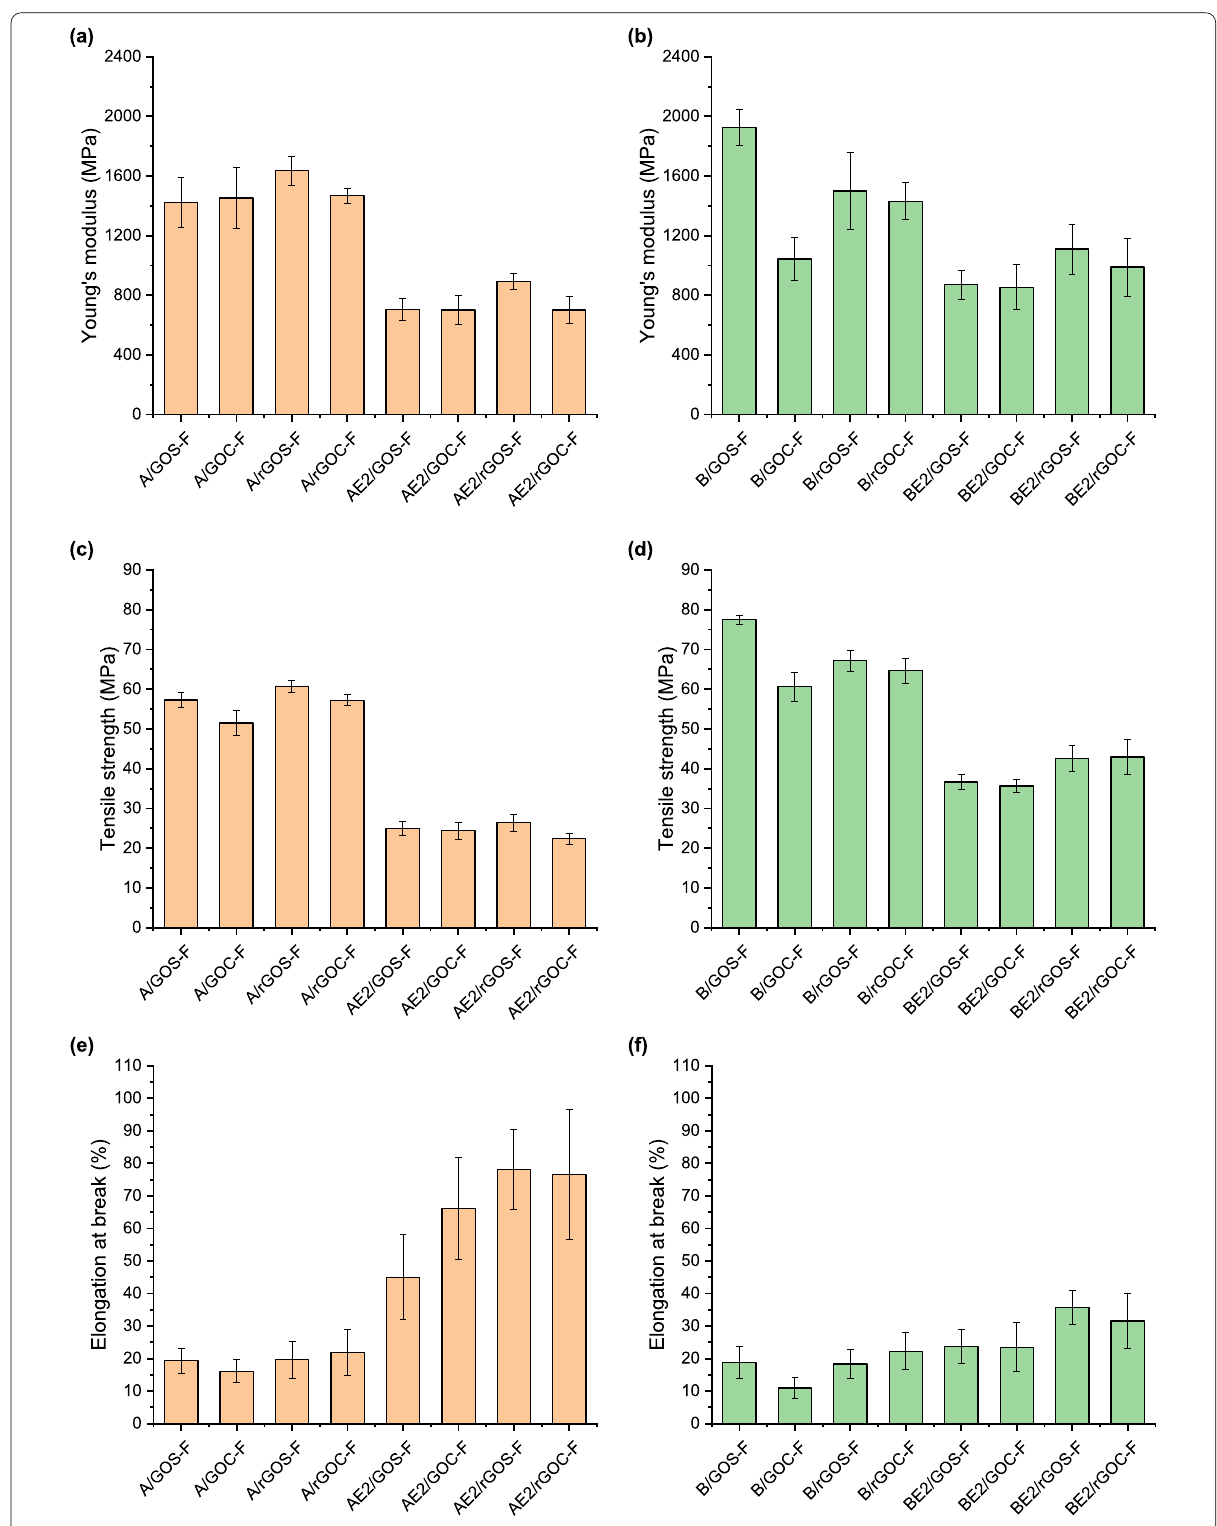
Fig. 6 Tensile mechanical properties ( a and b , tensile strength; c and d , Young’s modulus; e and f , elongation at break) of the different chitosan and chitosan/carboxymethyl cellulose (CMC)-based nanocomposite films. Error bars indicate standard